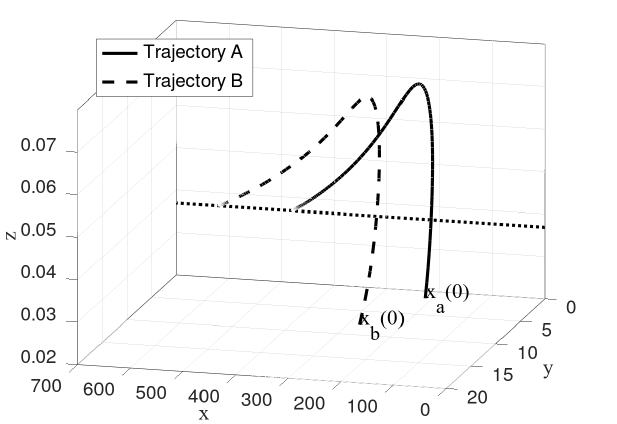
Figure 5. Phase diagram showing two trajectories resulting from simulations of the Droop model with two different initial conditions x a ( 0 ) , and x b ( 0 ) , shown in Figures 6 and 7. The parameters and initial conditions are shown in Figures 6 and 7. Note that both trajectories A and B are attracted to a stable region (dotted line) on the XZ -plane when z tends to the parameter zc 0 . We performed the simulation and plotting in Octave